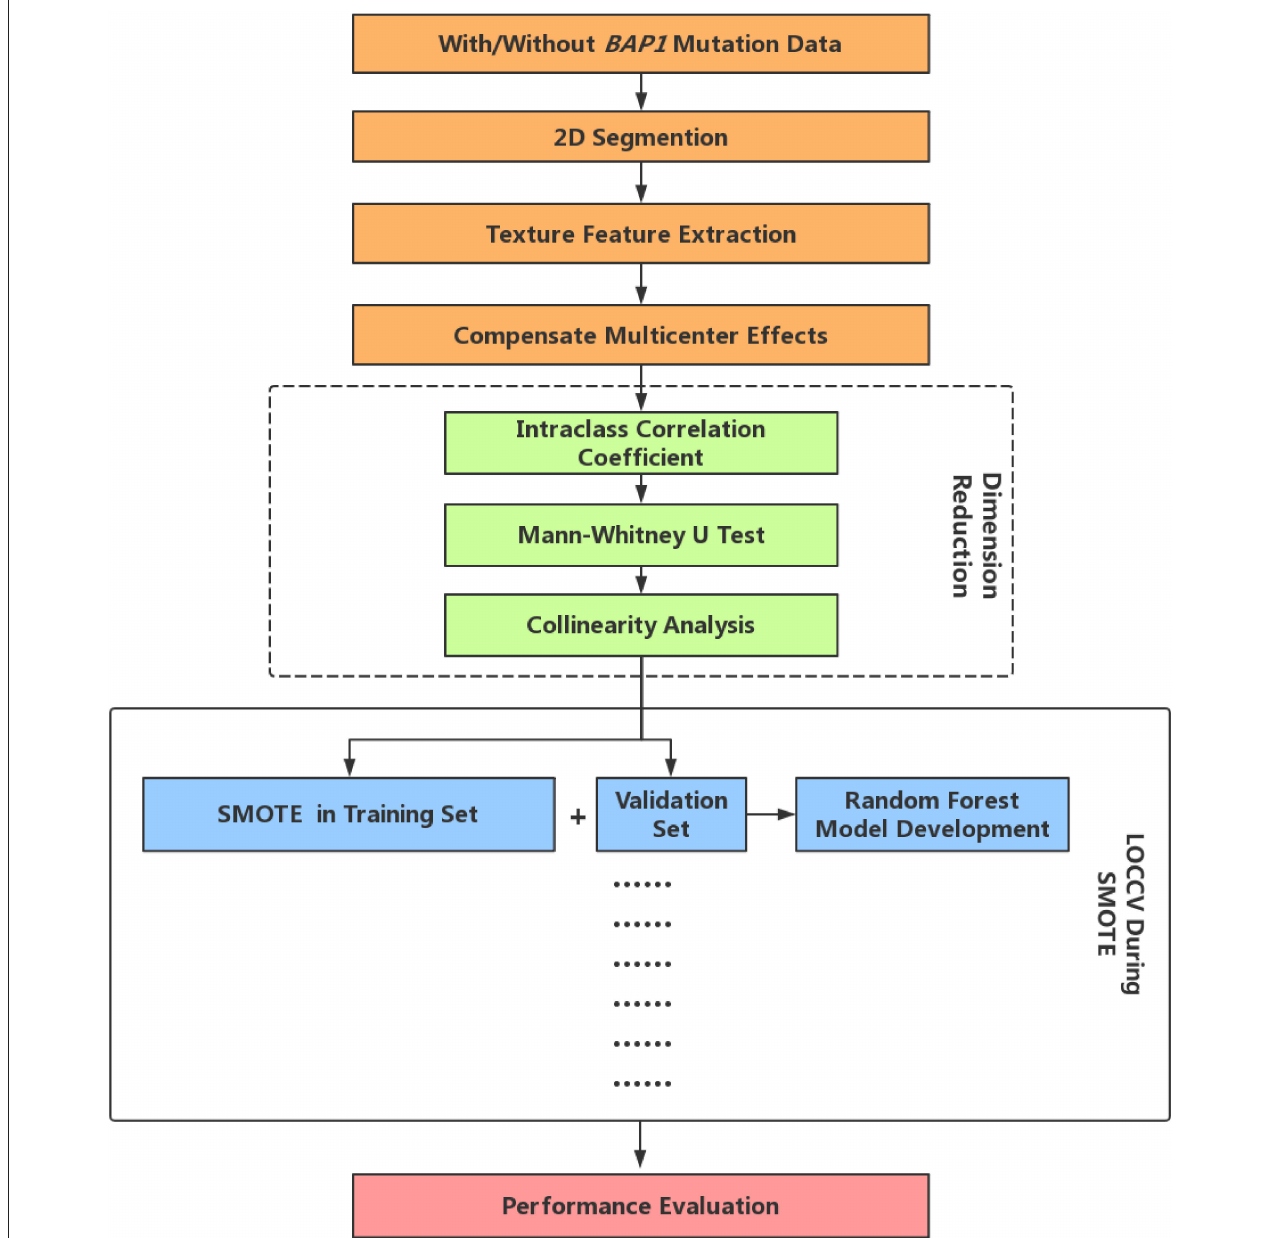
FIGURE 1 | Radiomics analysis pipeline. LOOCV, Leave-one-out-cross-validation; SMOTE, Synthetic Minority Over-sampling Technique.